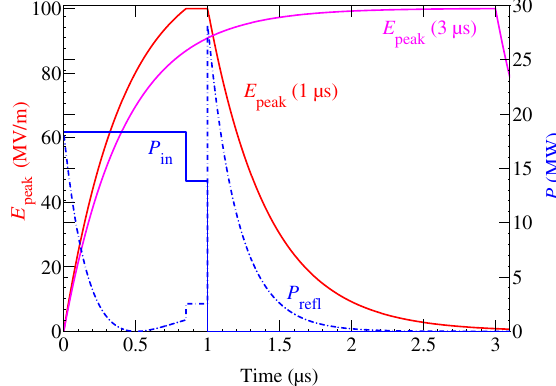
FIG. 11. Amplitude modulation scheme for the SwissFEL gun: input rf power (solid blue line), reflected power (dash-dotted blue line), and resulting peak gradient (red line) as a function of time for the nominal modulated rf pulse of 1 μ s total length. For comparison, the peak gradient for an unmodulated 3 μ s pulse is also shown (magenta line) [28].